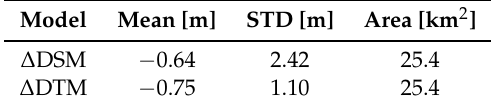
Figure 28. Urban subset ( left ) and suburban dataset ( right ). Shown are ( a , b ) ortho image, ( c , d ) extracted DSM, ( e , f ) derived DTM and ( g , h ) according nDSM in relief view. Table 14. Statistics of height differences between LiDAR and Pléiades based DSM and DTM for the Innsbruck stereo data